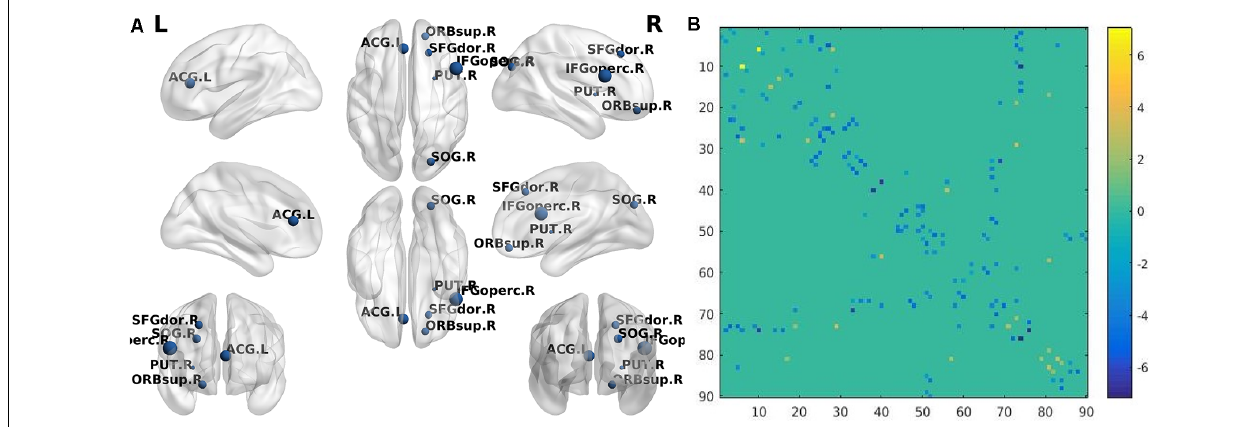
FIGURE 2 | (A) The brain regions (nodes) visualized by BrainNet Viewer (NKLCNL, Beijing Normal University) demonstrate significantly different betweenness centrality (BC) when subcortical ischemic vascular dementia (SIVD) was compared with NC ( p < 0.001, FDR-corrected). SFGdor.R: right frontal_sup; ORBsup.R: right frontal_sup_orb; IFGoperc.R: right frontal_inf_oper; ACG.L: left cingulum_ant; SOG.R: right occipital_sup; PUT.R: right putamen. (B) The structural connectivity alterations between the SIVD and NC groups. Horizontal axis and vertical axis respectively represent 90 brain regions in the automated anatomical labeling (AAL) template. The dots in different locations in the matrix represent the structural connectivity between the two different brain regions identified by horizontal axis and vertical axis. The colors of the dots represent structural connection strength, quantified by the values on the right of the color bar. The dot color with a positive value represents increased structural connection between the two brain regions in the SIVD group, compared with the NC group, while the dot color with a negative value represents a decreased structural connection.